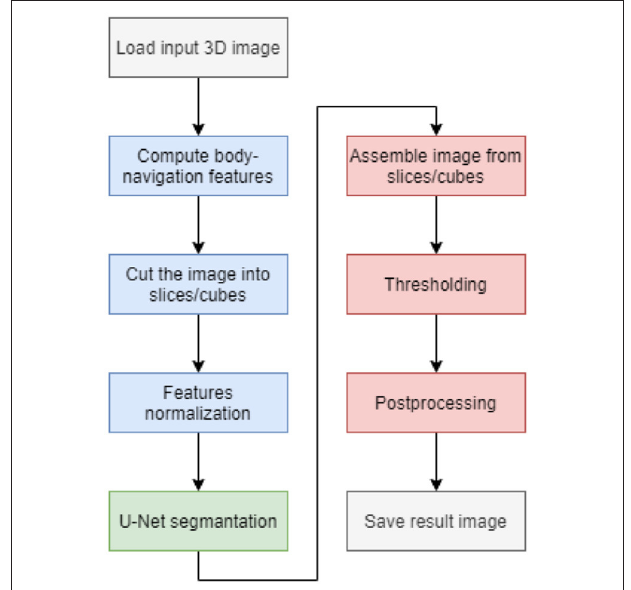
FIGURE 1 | Flowchart of the segmentation